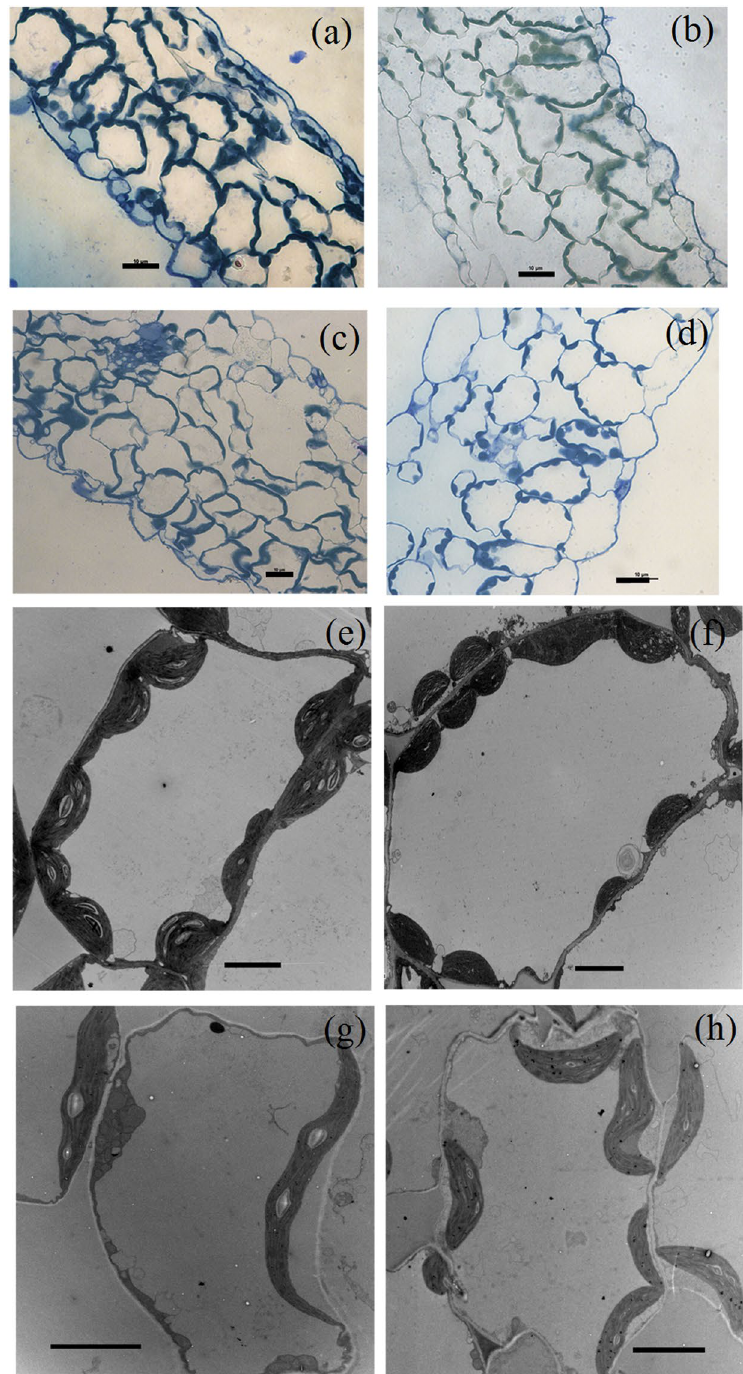
Figure 3. Light ( a – d ) and transmission electron ( e – h ) microscope images of Col-WT ( a , e ), Ws-WT ( b , f ), arc 12 ( c , g ) and arc 8 ( d , h ) leaves. Bars represent 10 μ m in ( a – d ) and 5 μ m in ( e and h